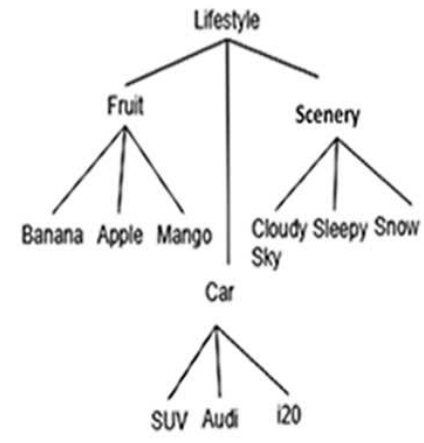
Figure 2. Result produced in Step